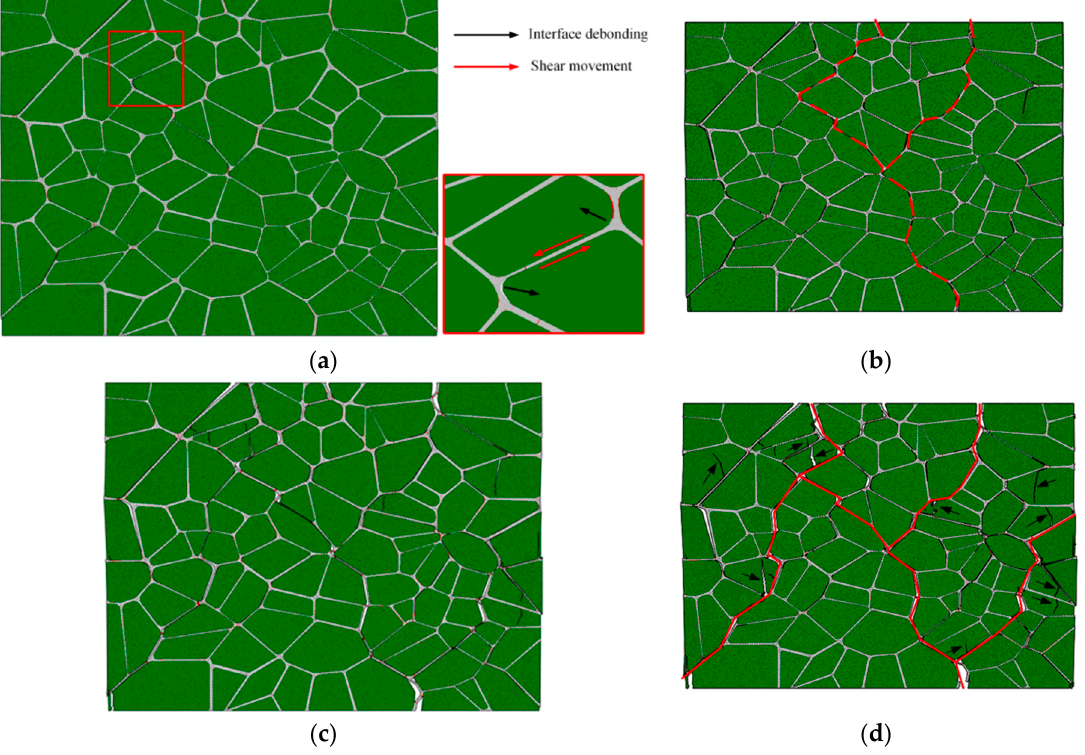
Figure 21. The failure evolution of PBX 9501 for different macroscopic strains, ( a ) 0.96%, ( b ) 1.2%, ( c ) 1.77%, and ( d ) 2.88%, under uniaxial compression at a strain rate of 10 − 3 s − 1 .